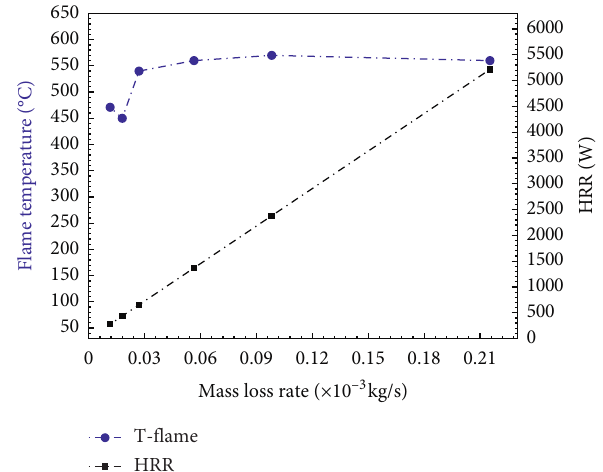
Figure 7: Variation of the flame temperature and the heat release rate according to the fire source: case of fire in free